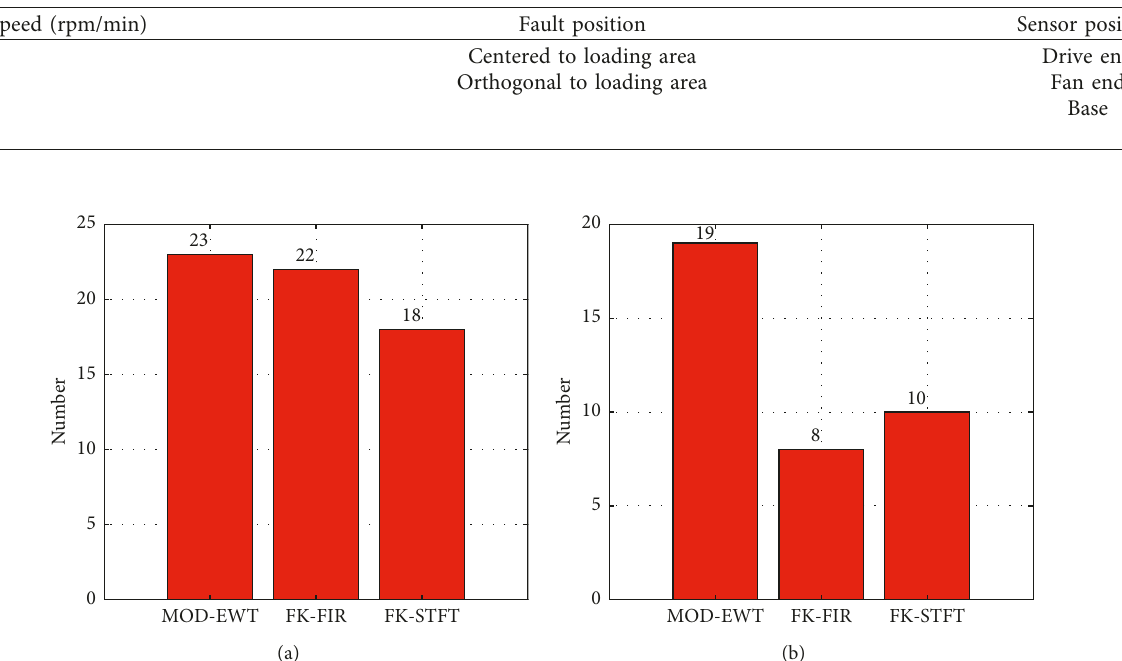
Table 9: Different conditions statement of 24 groups data.